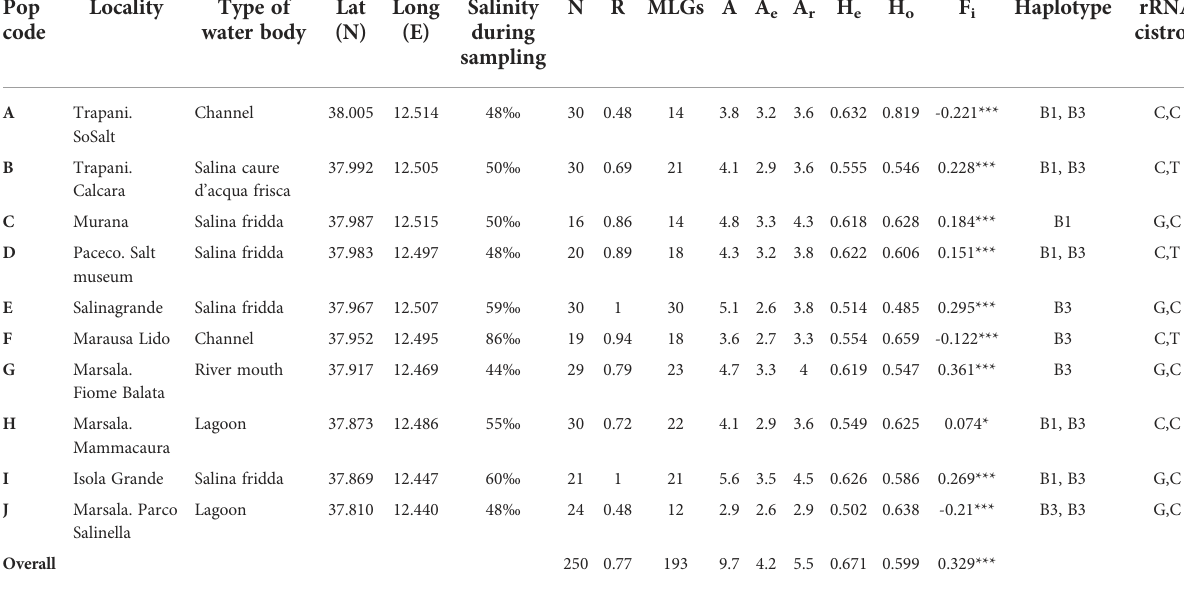
TABLE 1 Location details and population genetic variables of Ruppia spiralis in 10 Sicilian water